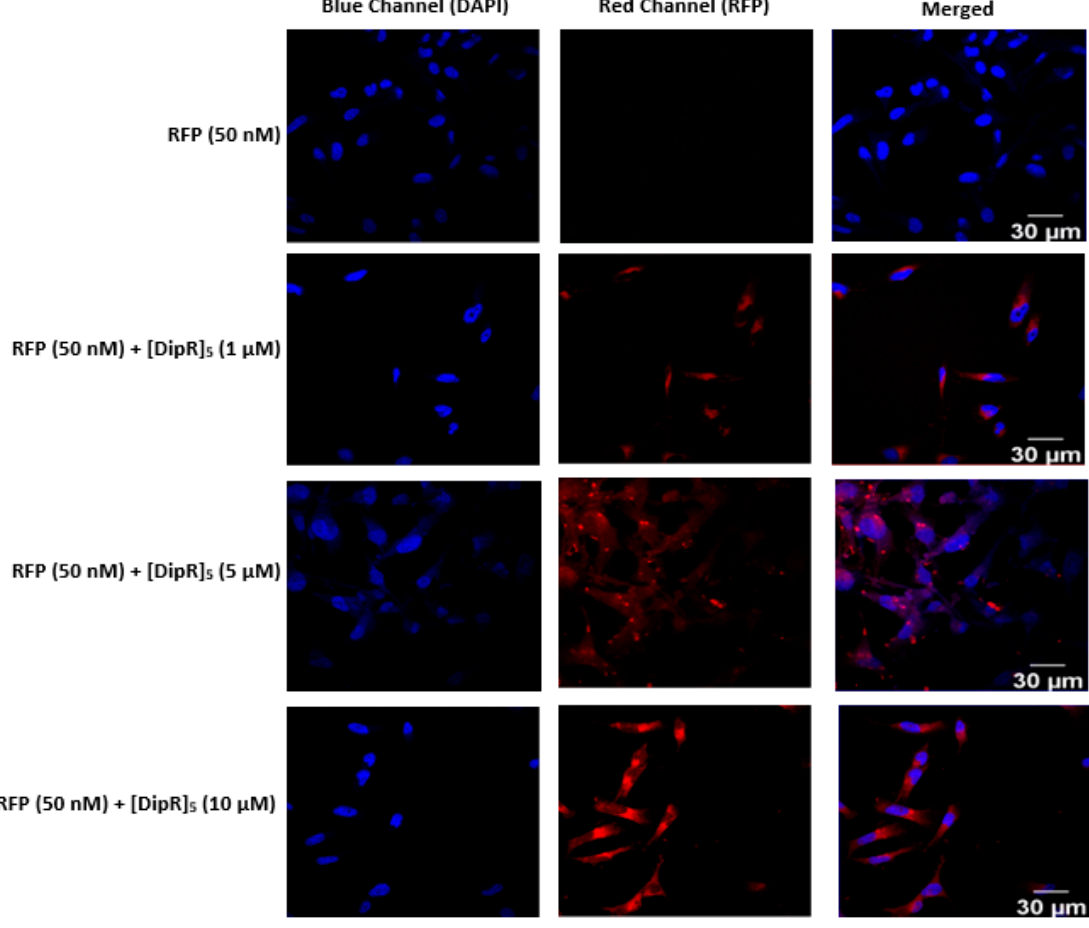
Figure 11. Confocal microscopy images of MDA-MB-231 cells incubated with the RFP-[DipR] 5 mixture at a peptide concentration (1–10 µM) and RFP at (50 nM) for 3 h. The red and blue channels visualize RFP and DAPI (used to stain the nucleus), respectively.